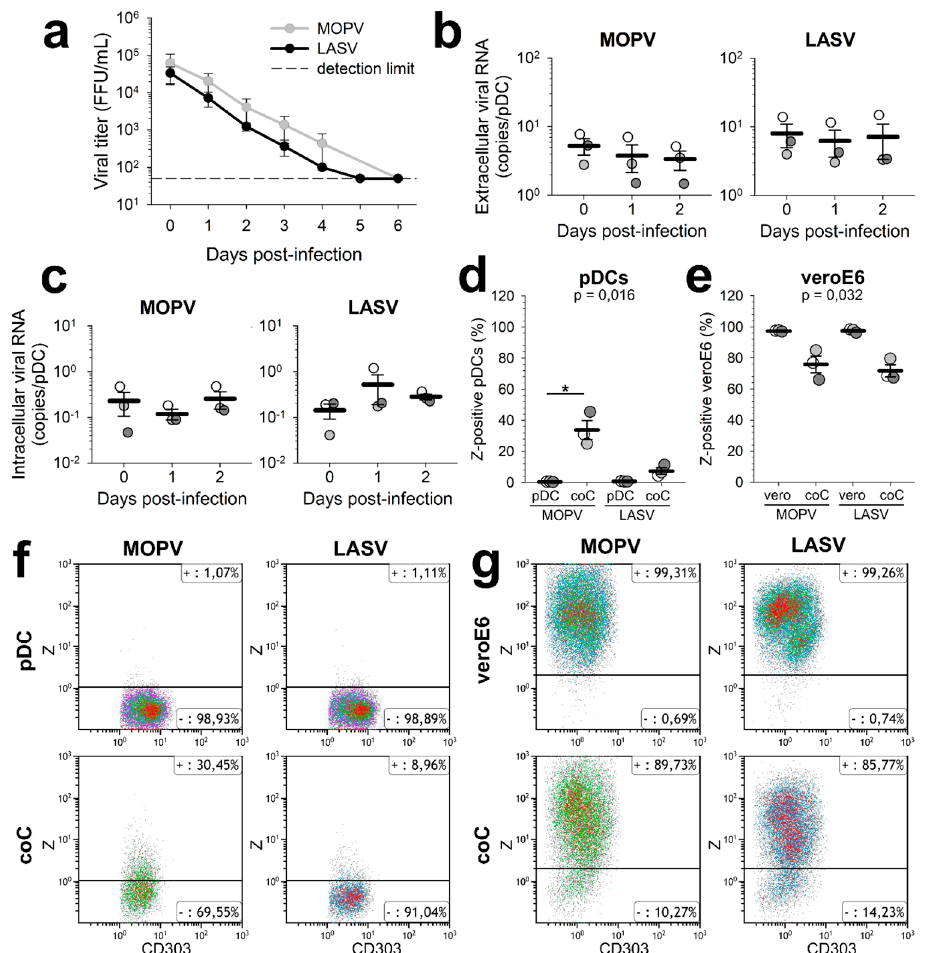
Figure 1. pDC infection by MOPV and LASV. ( a ) pDCs were infected with MOPV or LASV (MOI = 0.1) and infectious particles in the culture medium quantified. ( b , c ) pDCs were infected with MOPV or LASV (MOI = 0.1) for 1 h (day 0), 1 day, or 2 days. Viral RNA in the culture medium ( b ) or inside the cells ( c ) was quantified by RT-qPCR. ( d – g ) VeroE6 cells were infected with MOPV-Zflag or LASV-Zflag (MOI = 0.3). After 24 h, pDCs were added to the cells, or infected with MOPV-Zflag or LASV-Zflag (MOI = 0.1). 24 h later, cells were stained for phenotypic markers and the Z protein. Conditions were: infected VeroE6 ("veroE6"), VeroE6 cultured with pDCs ("coC"), and infected pDCs (“pDC”). Z-positive pDCs ( d – f ) and VeroE6 cells ( e – g ) were quantified by flow cytometry. All data are presented as the mean and standard error of mean (SEM) of three independent experiments. ANOVA on Ranks followed by pairwise comparisons (Tukey test) were performed. Differences are significant for p < 0.05. When significant, P values of the ANOVA are indicated on the graph. Significant pairwise comparisons are indicated by a star